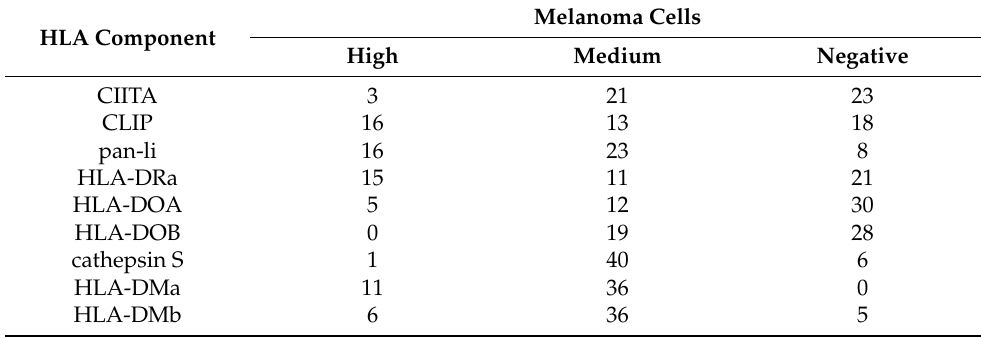
Table 3. Heterogeneous mRNA levels of HLA class II APM components in melanoma cell lines. HLA